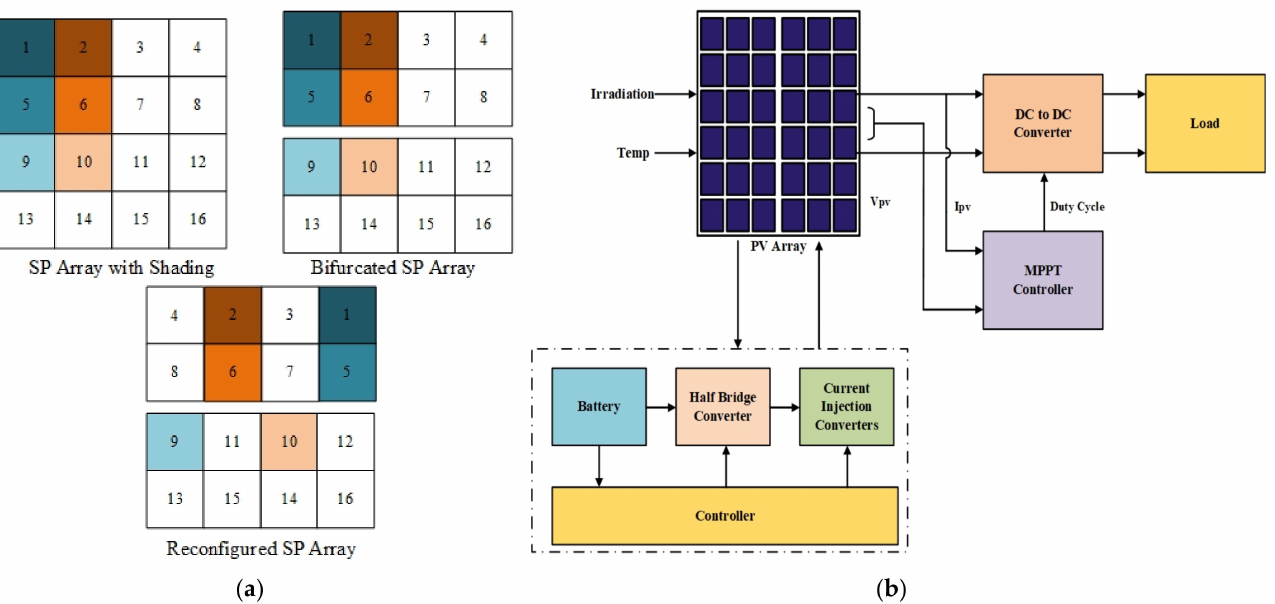
Figure 5. ( a ) Optimal reconfiguration scheme for a shaded PV array; ( b ) Half-Bridge Current Injection (HBCI)